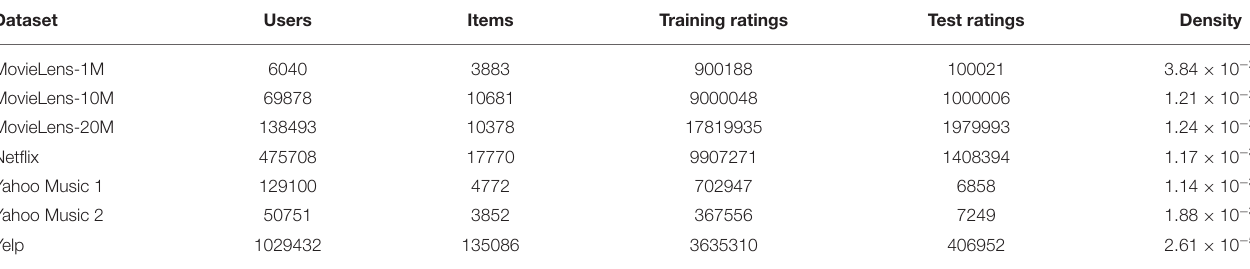
TABLE 7 | Basic statistics of datasets.